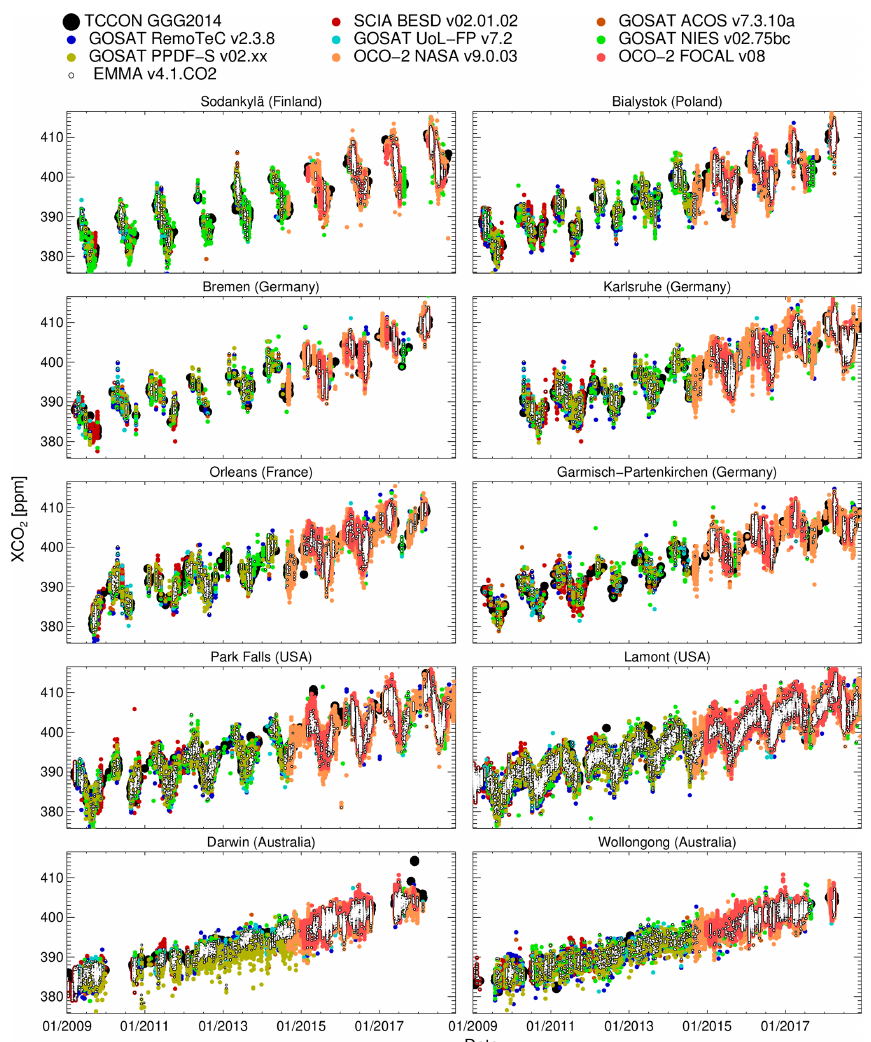
Figure A1. XCO 2 time series at 10 TCCON sites during January 2009–December 2018 as obtained using the EMMA quality assessment method. TCCON GGG2014 XCO 2 is shown as thick black dots, the individual satellite L2 input products are shown as colored dots, and the EMMA product is shown as white circles with black borders. The derived numerical values are listed in Table